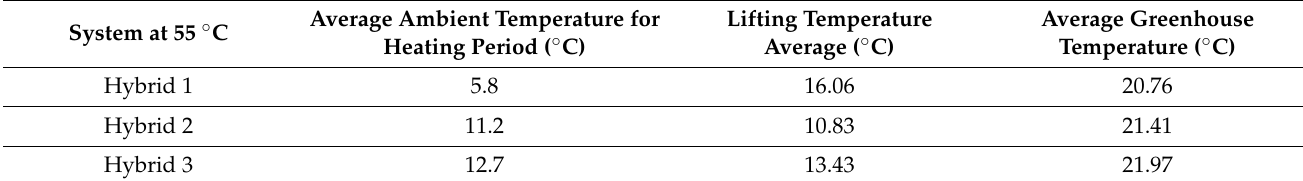
Table 4. Summary of experimental results.